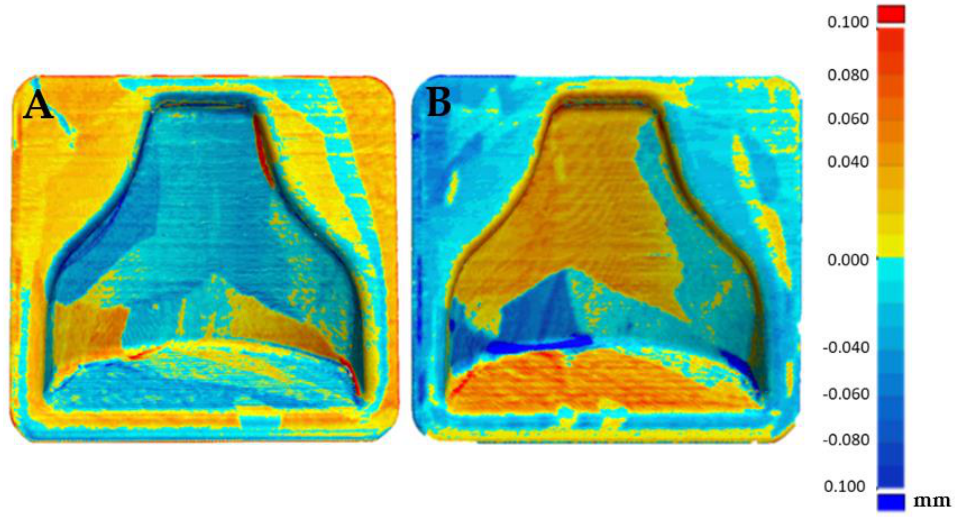
Figure 14. Comparison between the scan of mold 1 pre and post smoothing ( A ) and comparison of mold 2 pre and post smoothing ( B ).